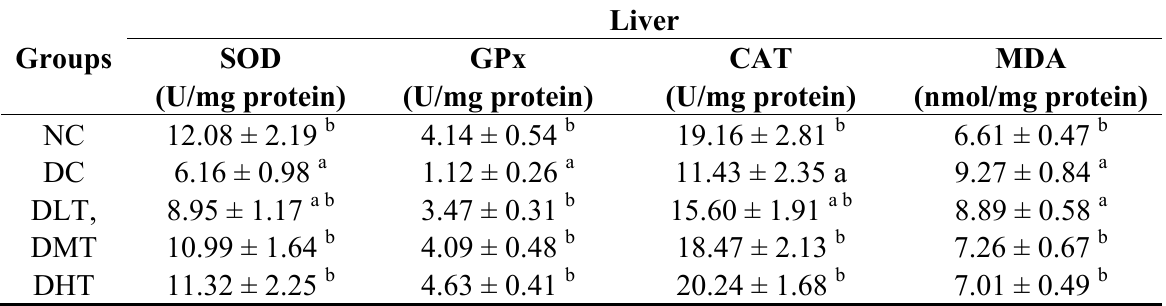
Table 3. Effect of salidroside administration on antioxidant enzymes activities and MDA levels in liver in